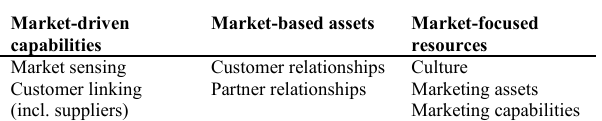
Table 1: Market related